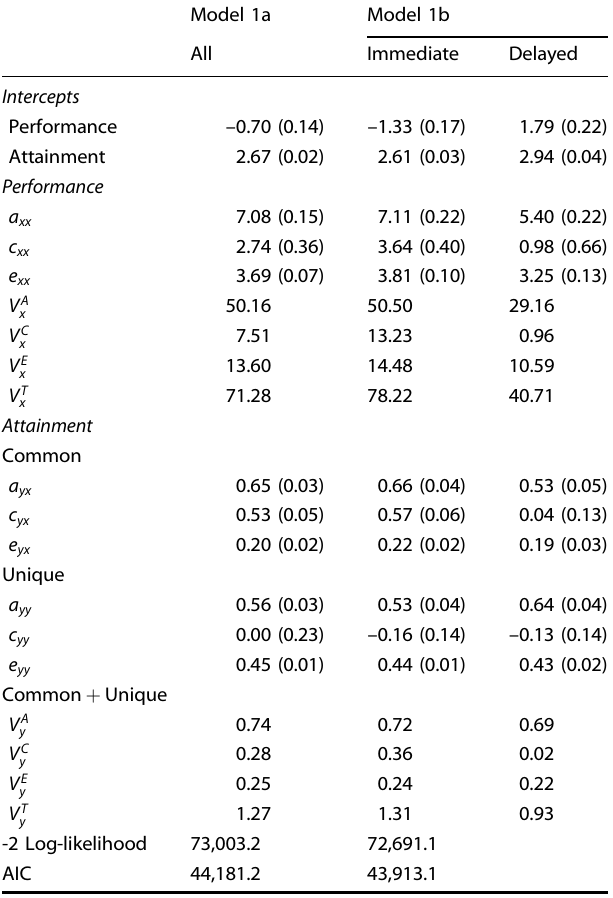
Table 1. Bivariate Cholesky ACE-decomposition of educational performance and attainment overall and split by timing of tracking ( N =